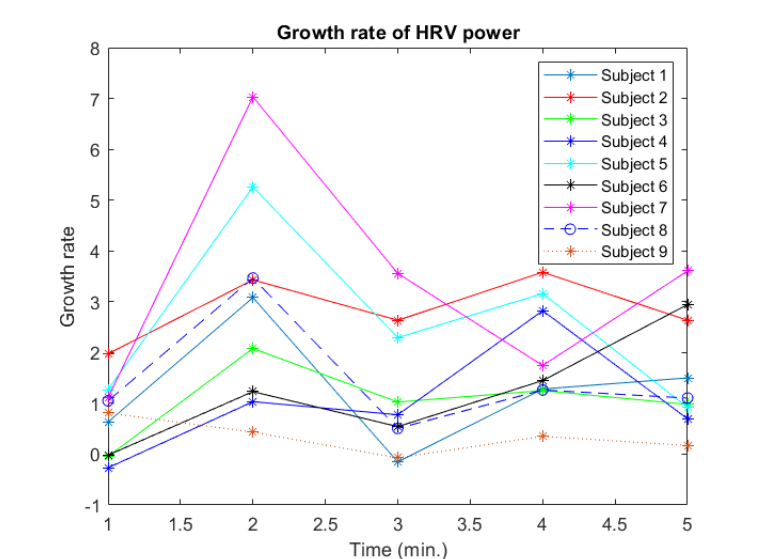
Figure 10. Experiment 3 growth rate of HRV